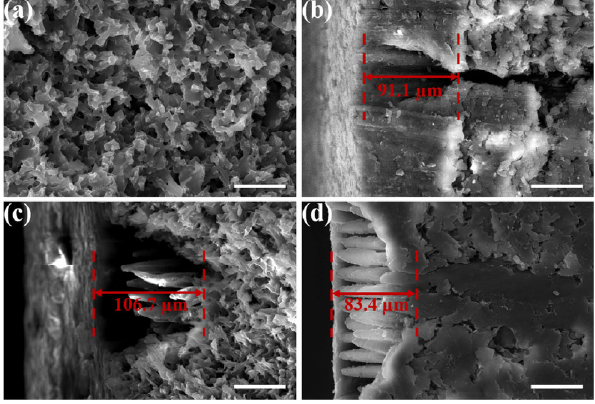
Fig. 3 Cross-sectional morphology (scale bar: 50 µm) of (a) PPI, (b) HPPI-T50, (c) HPPI-T100, and (d) HPPI-T150. approximately 90 μ m (HPPI-T50: 91.1 μ m, HPPI-T100: 106.7 μ m, HPPI-T150: 83.4 μ m). The surface and cross-